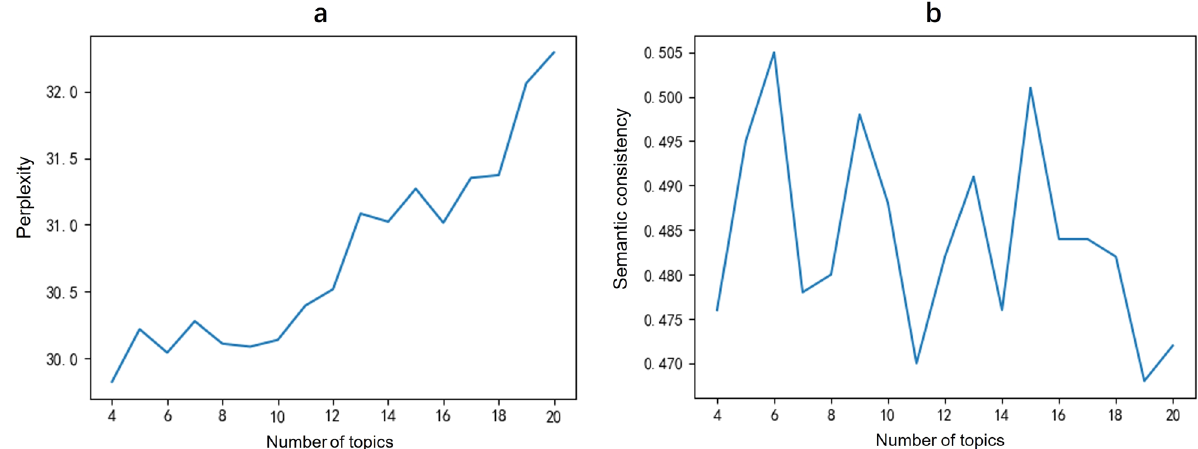
Fig. 5 Evaluations of LDA topic model. The evaluation indicators of the LDA topic model. a Perplexity and b semantic consistency vary with the number of topics.